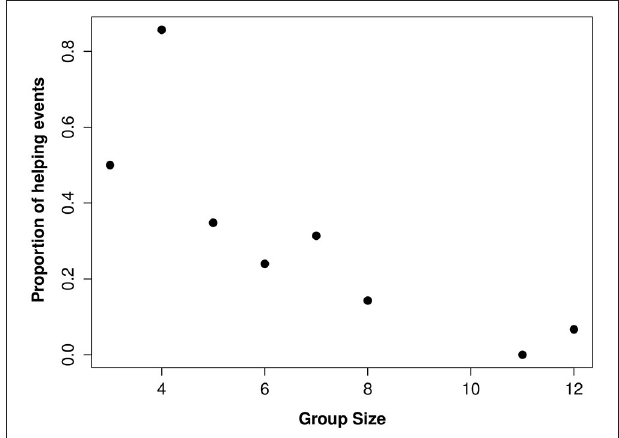
FIGURE 1 | The relationship between group size and proportion of brood observations where a helper contributed to offspring